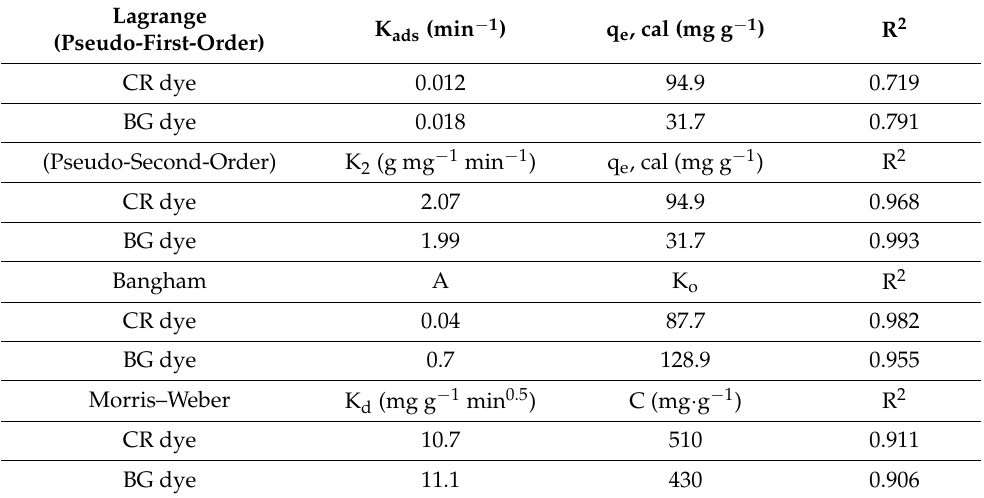
Table 1. Kinetics parameters for the sorption of CR and BG dyes on the NLS/Cs/Alg.